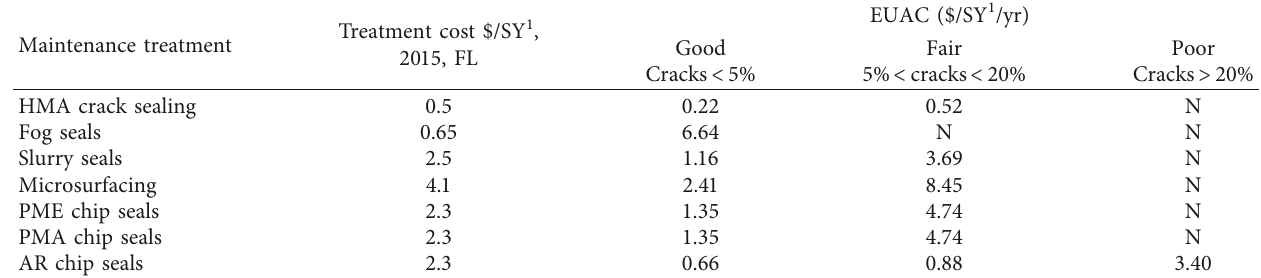
Table 2: Pavement treatment EUAC.